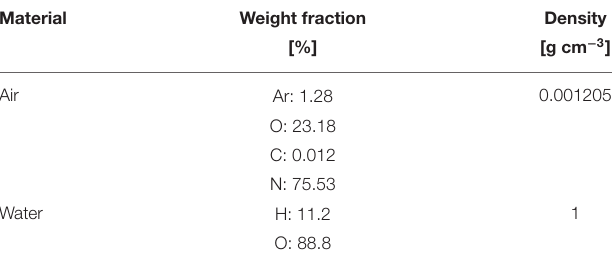
TABLE 2 | Composition of materials used for the gamma dose simulations in MCNPX. Material